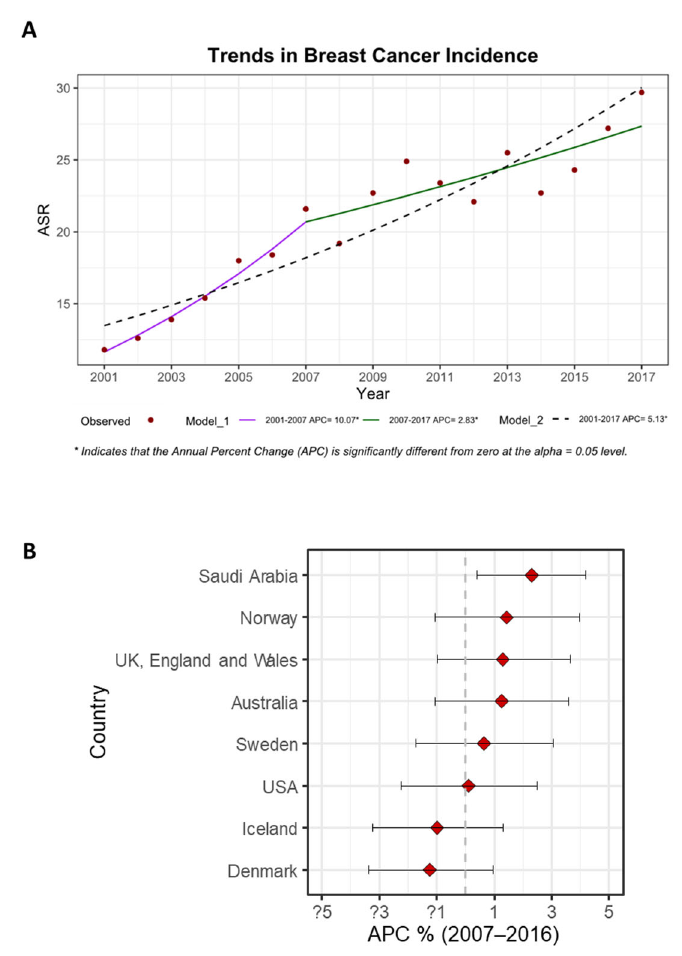
Figure 5. Trends in breast cancer incidence. ( A ) Jointpoint regression analysis of breast cancer Overall Age-Standardized Incidence Rate (ASR) in the Saudi female population for the period of 2001–2017. The estimated Annual Percent Change (APC) for two modules (Module_1 and Module_2) is displayed at the bottom of the figure, (* indicates p < 0.05). ( B ) Estimated Annual Percent Change (APC) of Overall Age-Standardized Incidence Rate (ASR) for selected countries in comparison to Saudi Arabia (2007–2016). Data for other countries were acquired from the International Agency for Research on Cancer (IARC) [17].